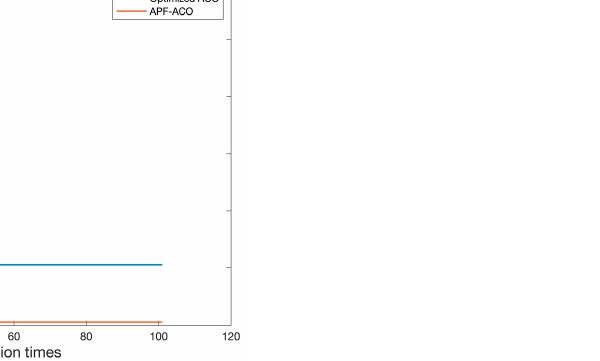
Figure 13. Comparison of Convergence Speed of APF-ACO and Optimized ACO Algorithms.